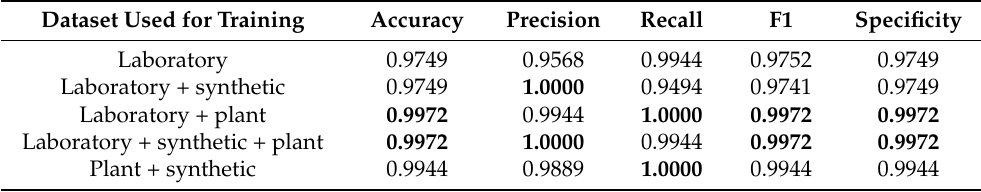
Table 6. Results of the Climatronic